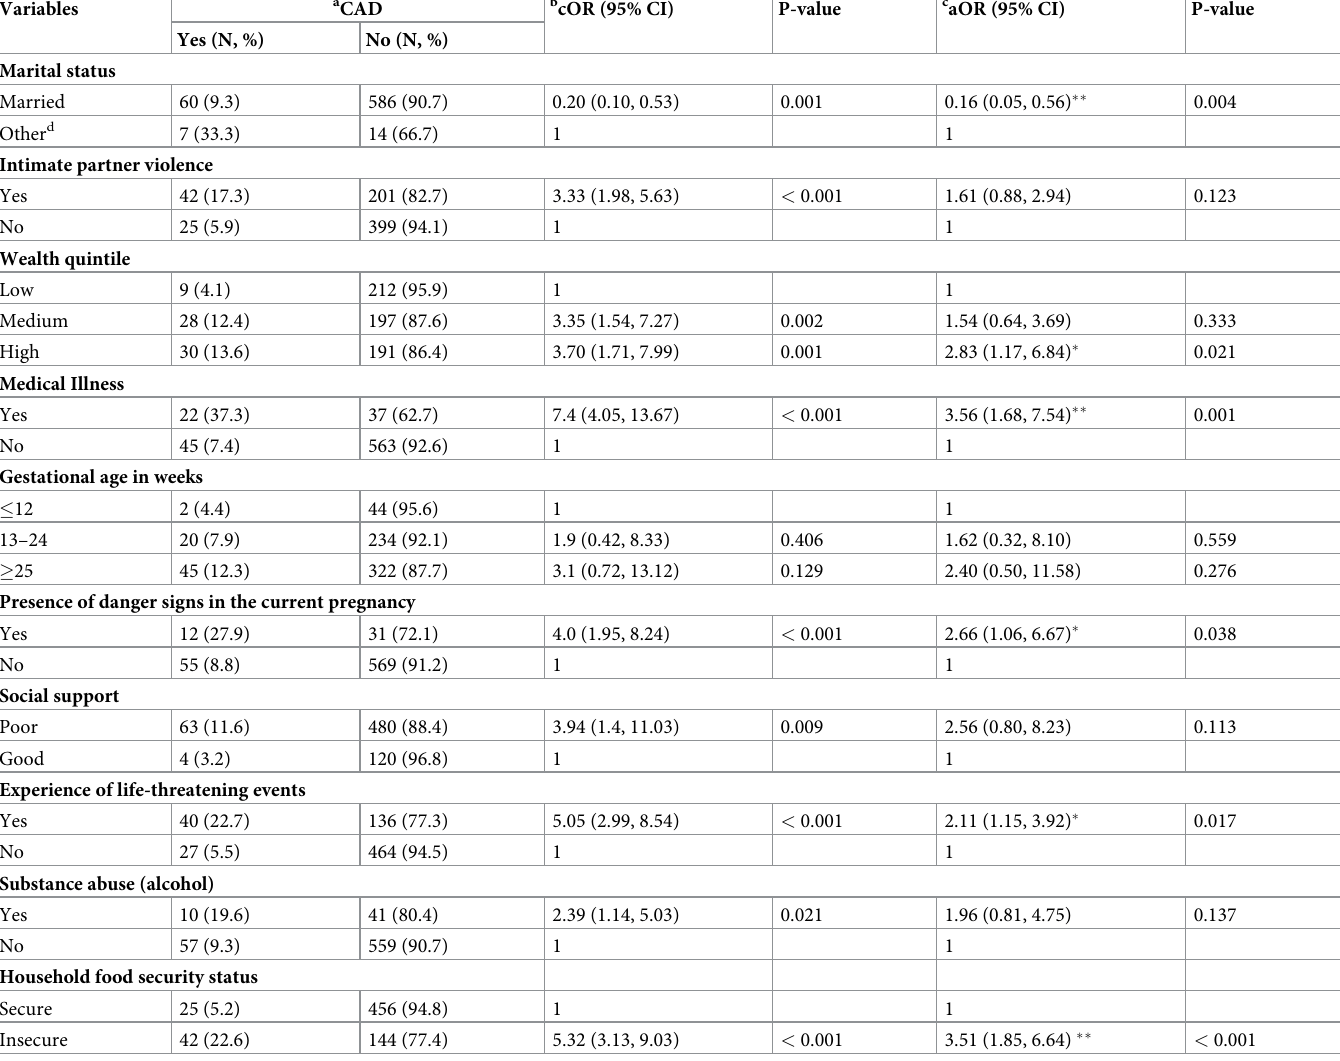
Table 3. Factors associated with comorbid anxiety and depression among pregnant women in Arba Minch Zuria district, Gamo zone, Southern Ethiopia, 2019, (n = 667).